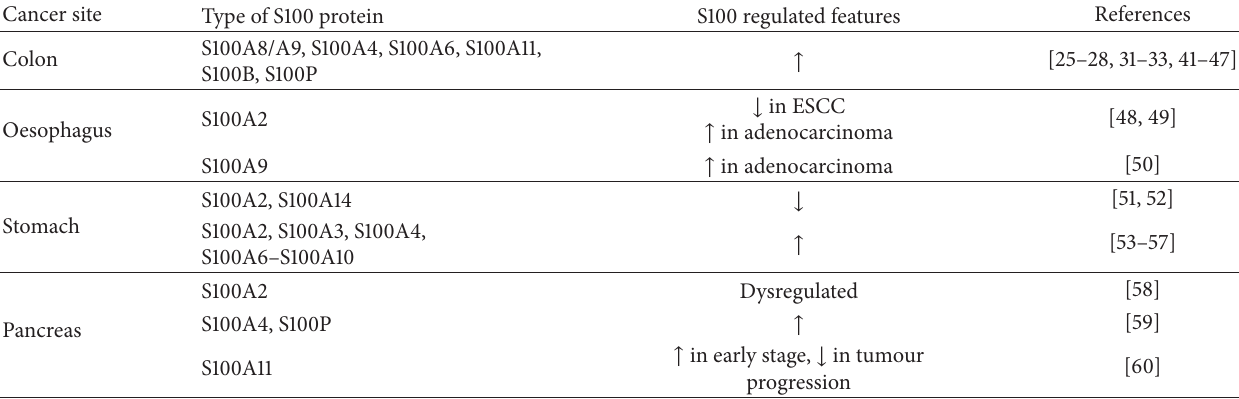
Table 1: Association of S100 proteins with different types of gastrointestinal